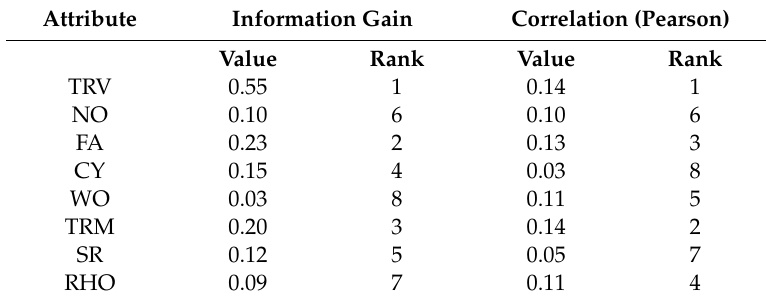
Table 6. Information Gain and Pearson’s correlation coe ffi cient for all input parameters, which were also ranked based on each index. Attribute Information Gain Correlation